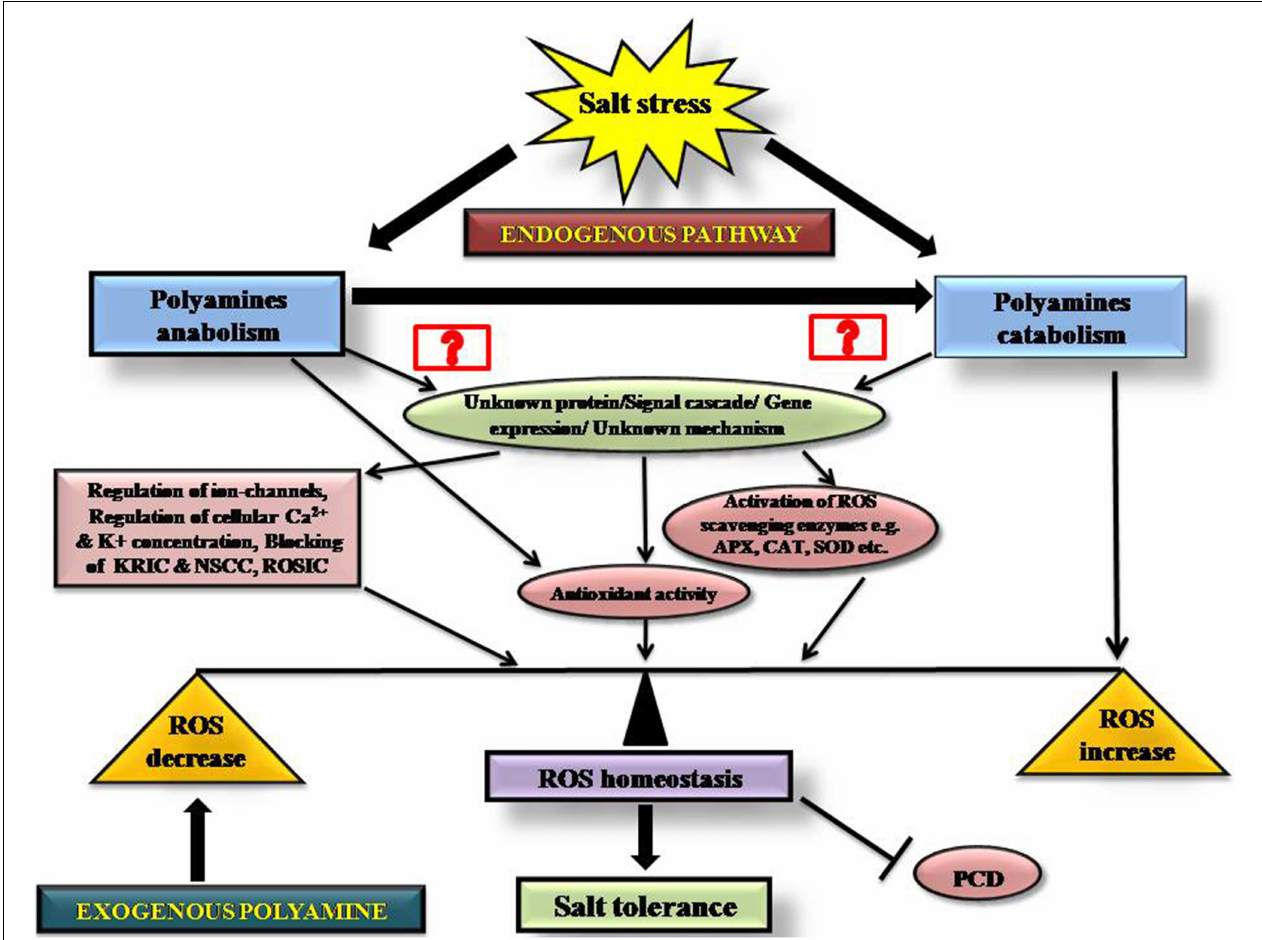
FIGURE 4 | Schematic diagram showing the role of endogenous and exogenous polyamines in maintaining redox homeostasis during salinity stress.